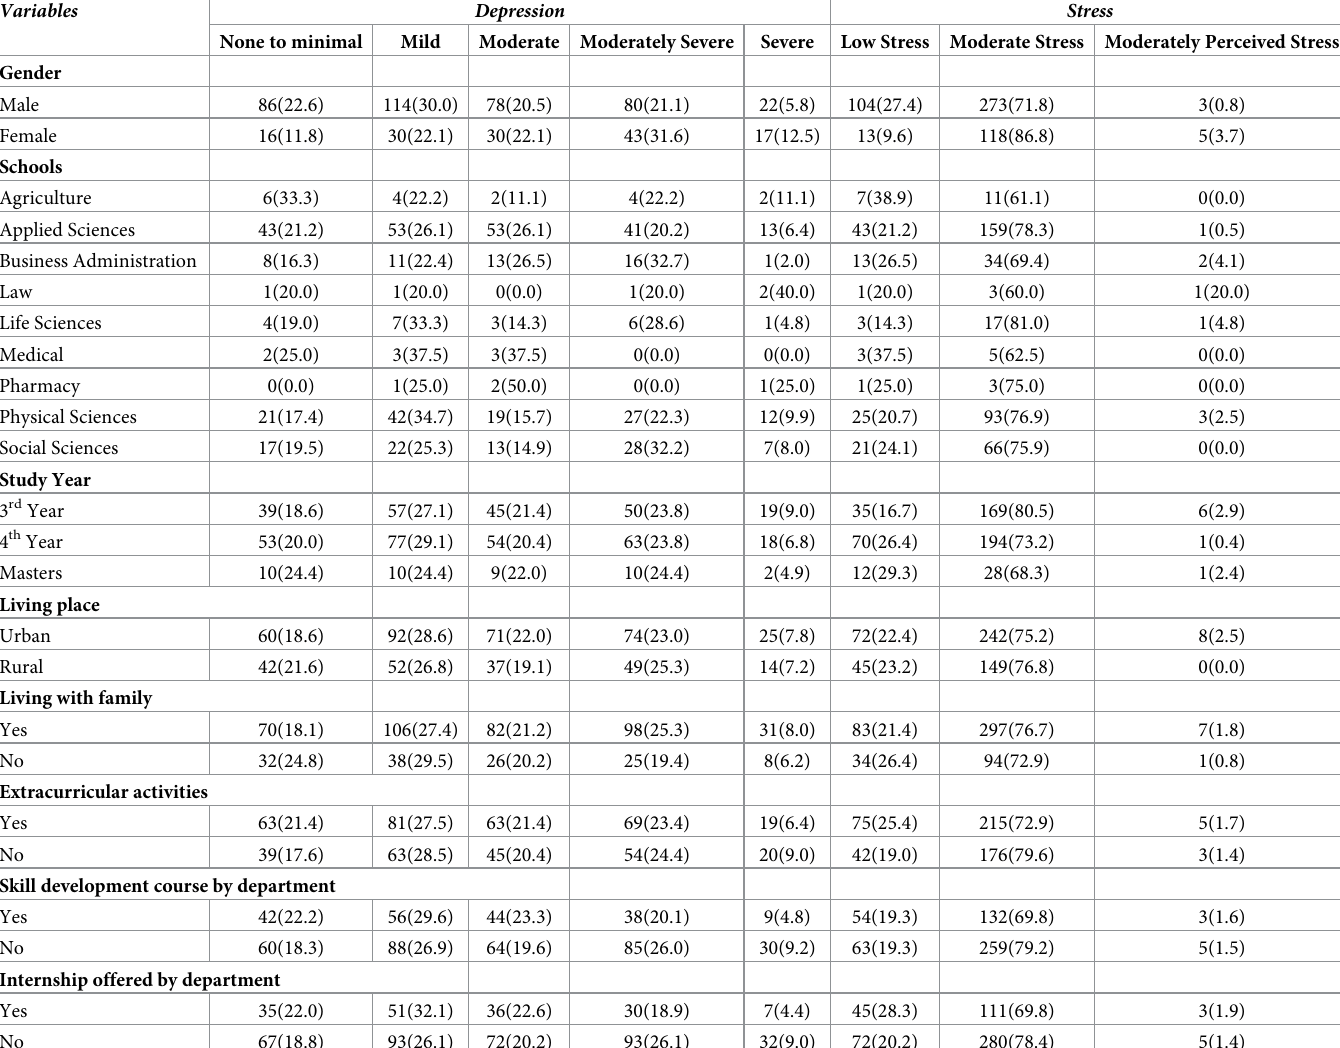
Table 2. Results of Patient Health Questionnaire (PHQ-9) and Perceived Stress Scale